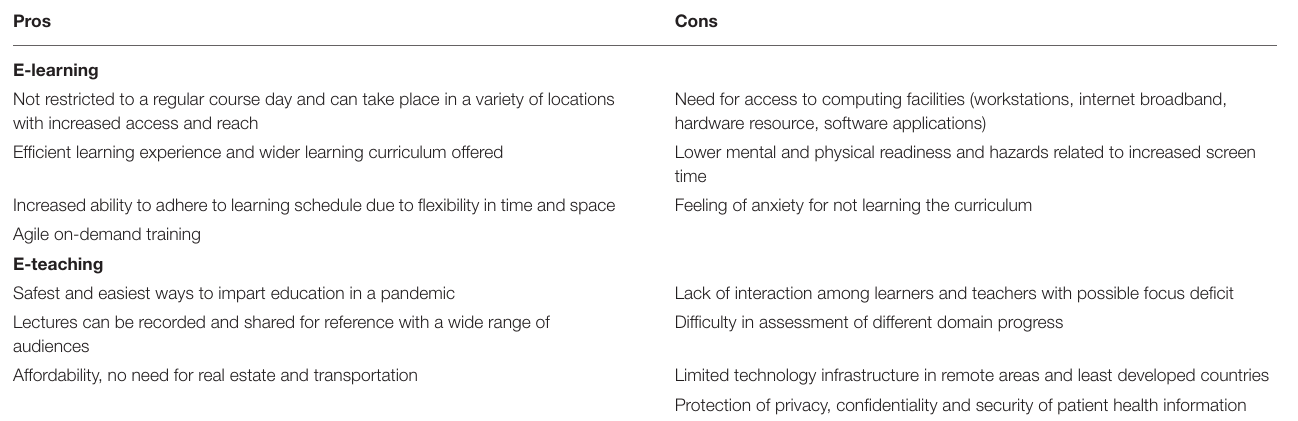
TABLE 1 | General pros and cons of e-teaching and e-learning. Pros